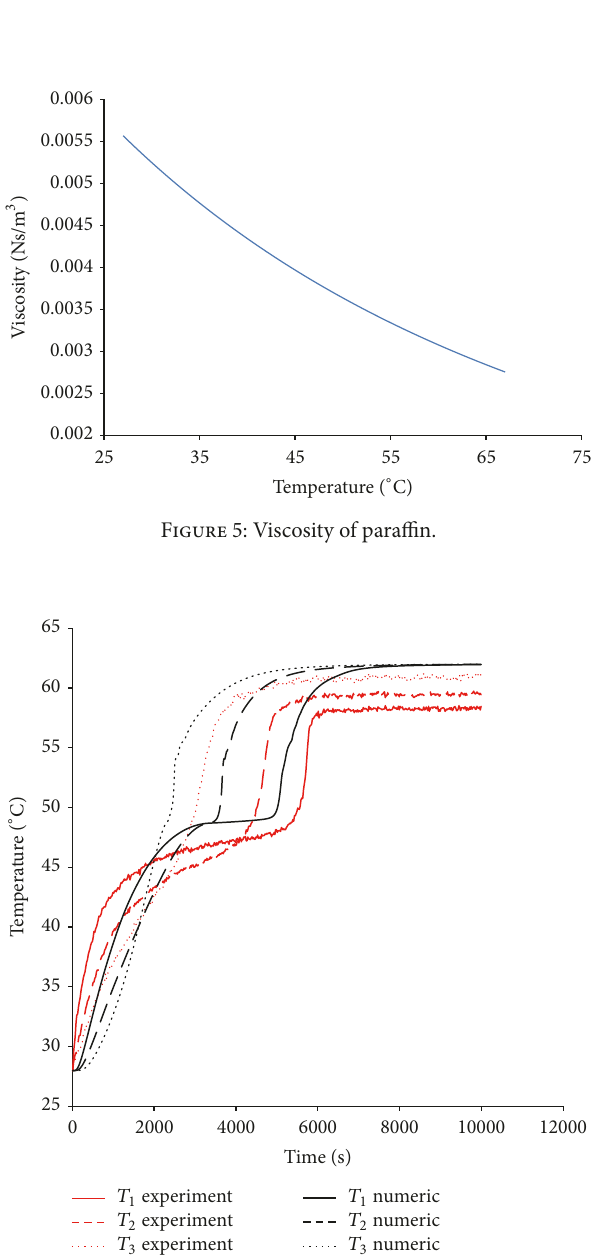
Figure 6: The comparison of temperature distribution of